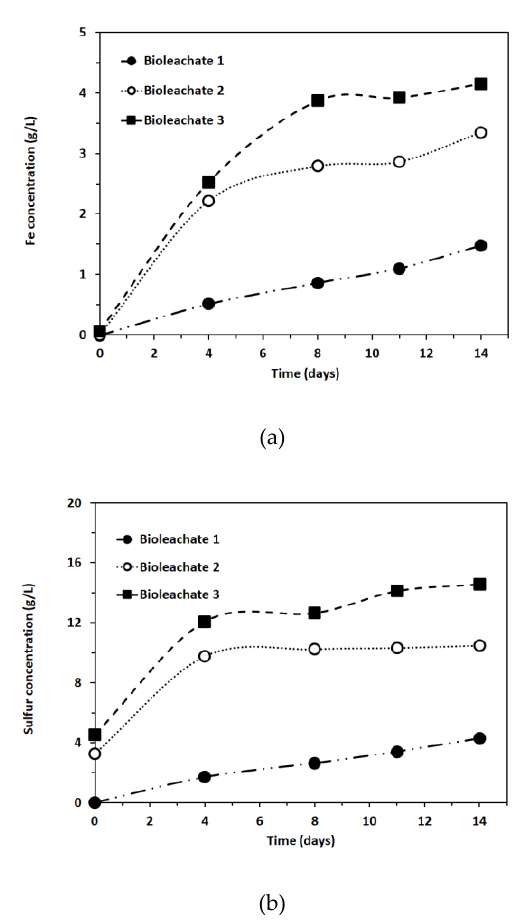
Figure 4. Variation of iron (Fe) and sulfur (S) concentration in solution as a function of time during the bacterial oxidation process. ( a ): Iron; ( b ): Sulfur.